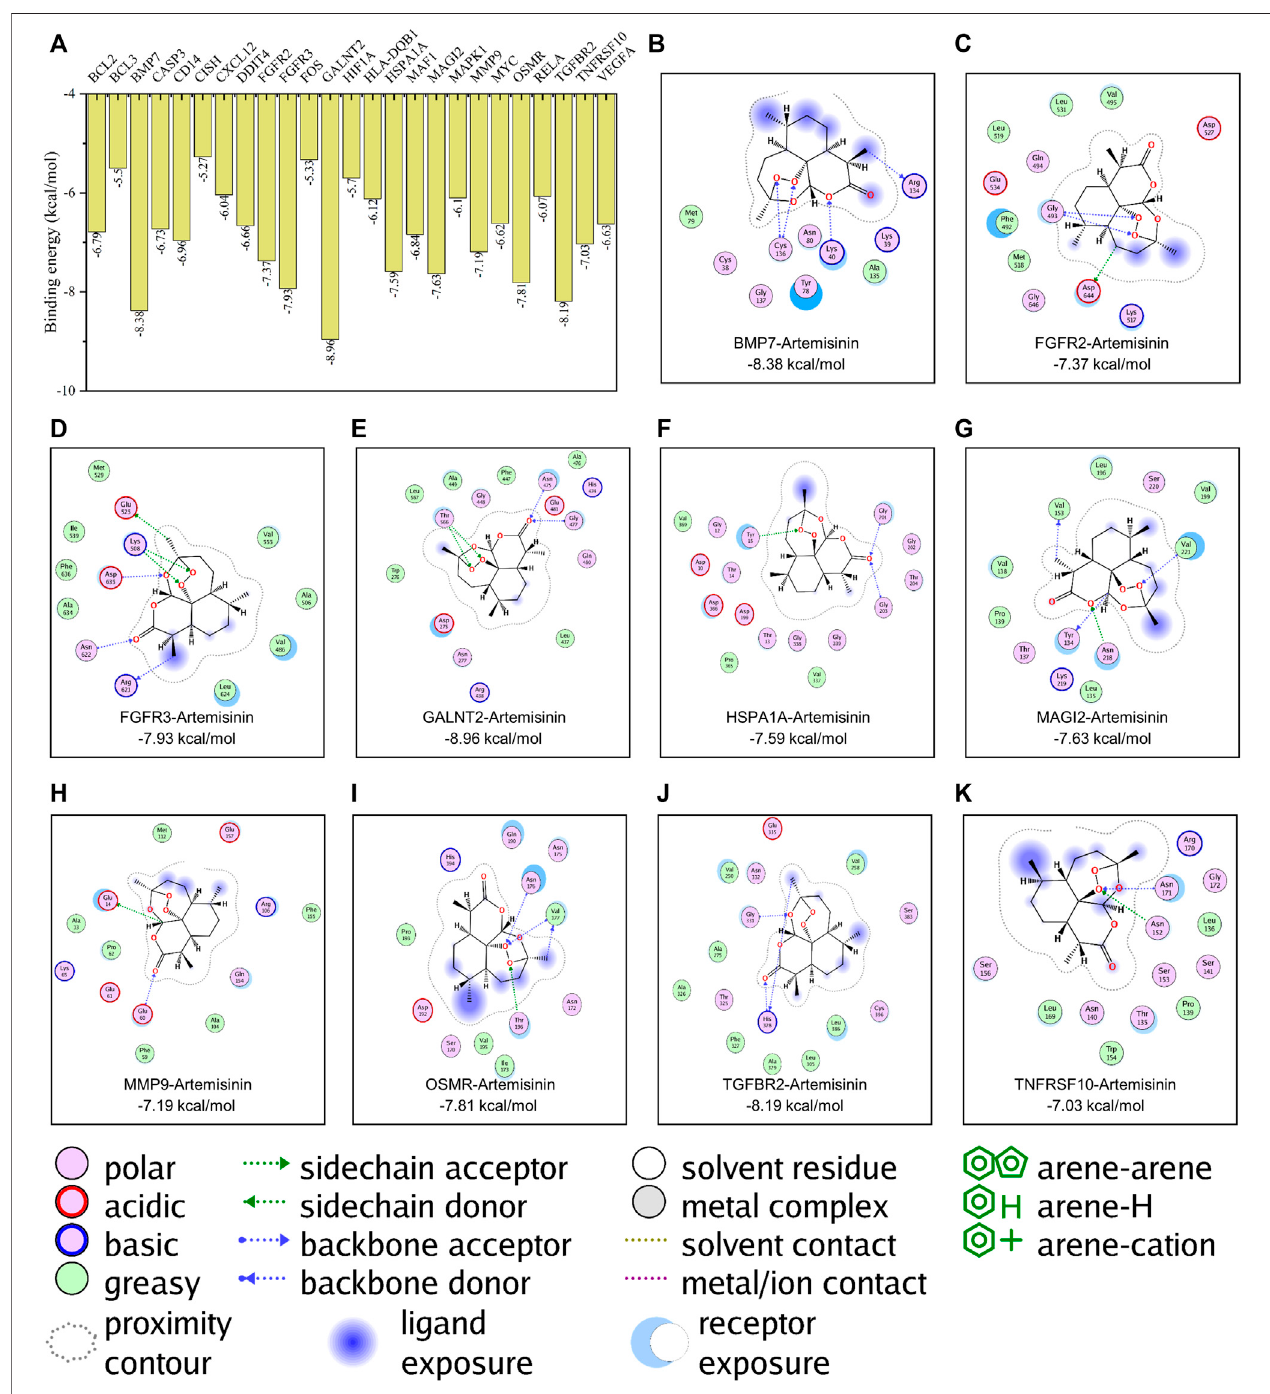
FIGURE 2 | Molecular docking simulation of artemisinin with kernel targets. (A) The results of the binding energy between artemisinin and the protein. (B – K) . The docking pattern of artemisinin with the af fi nity top 10 kernel protein respectively.